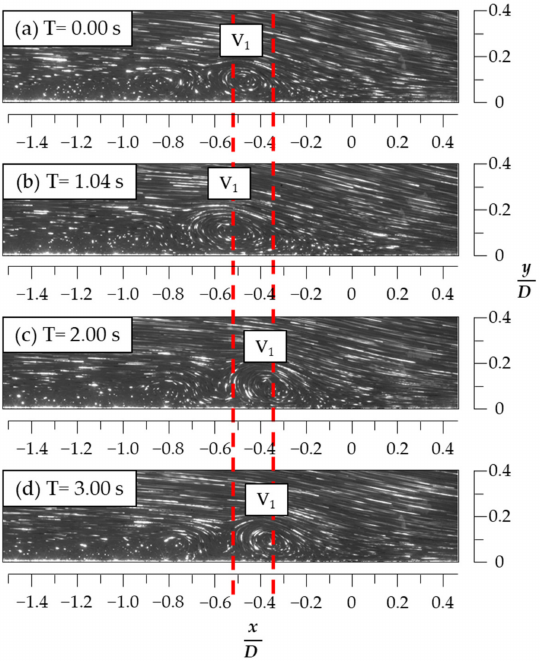
Figure 10. Time-series flow visualization of the HSV’s kinematic mode: “oscillation with a small displacement” in the z = 0.8 cm plane when H / D = 1.5. The two red dashed lines indicate the oscillation range of the core of the HSV closest to the LE (labeled V 1 ) between x / D = − 0.34 and − 0.52.